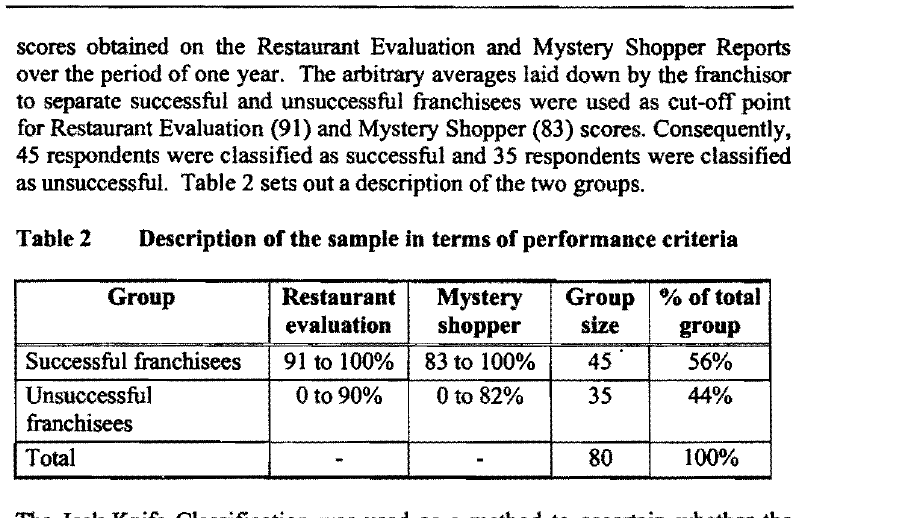
Description of tbe sample in terms of performance criteria